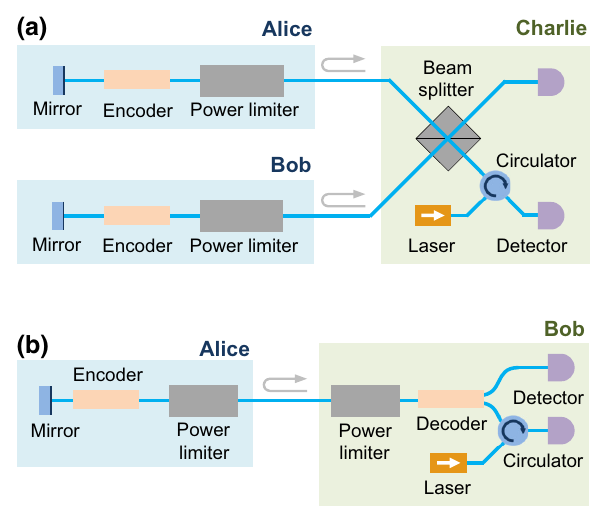
FIG. 9. Schematics of the power limiter used in (a) a plug- and-play MDI-QKD system and (b) a plug-and-play BB84 QKD